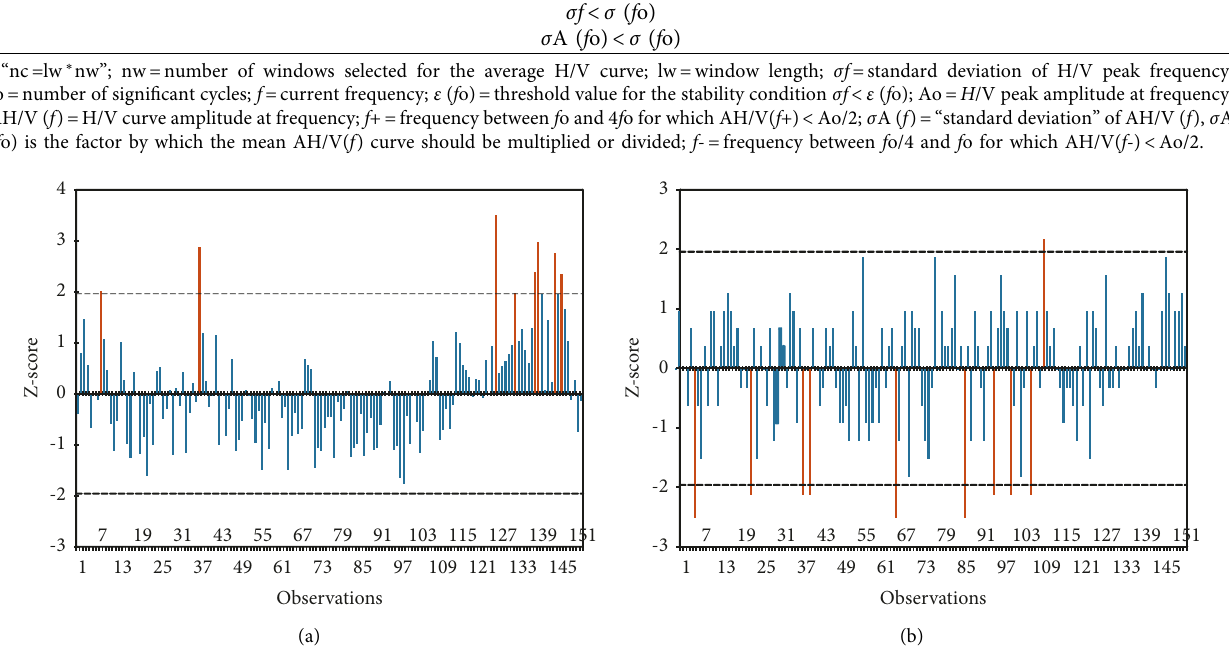
Criteria for a clear HVSR curve peak (at least 5 out of 6 criteria fulfilled)